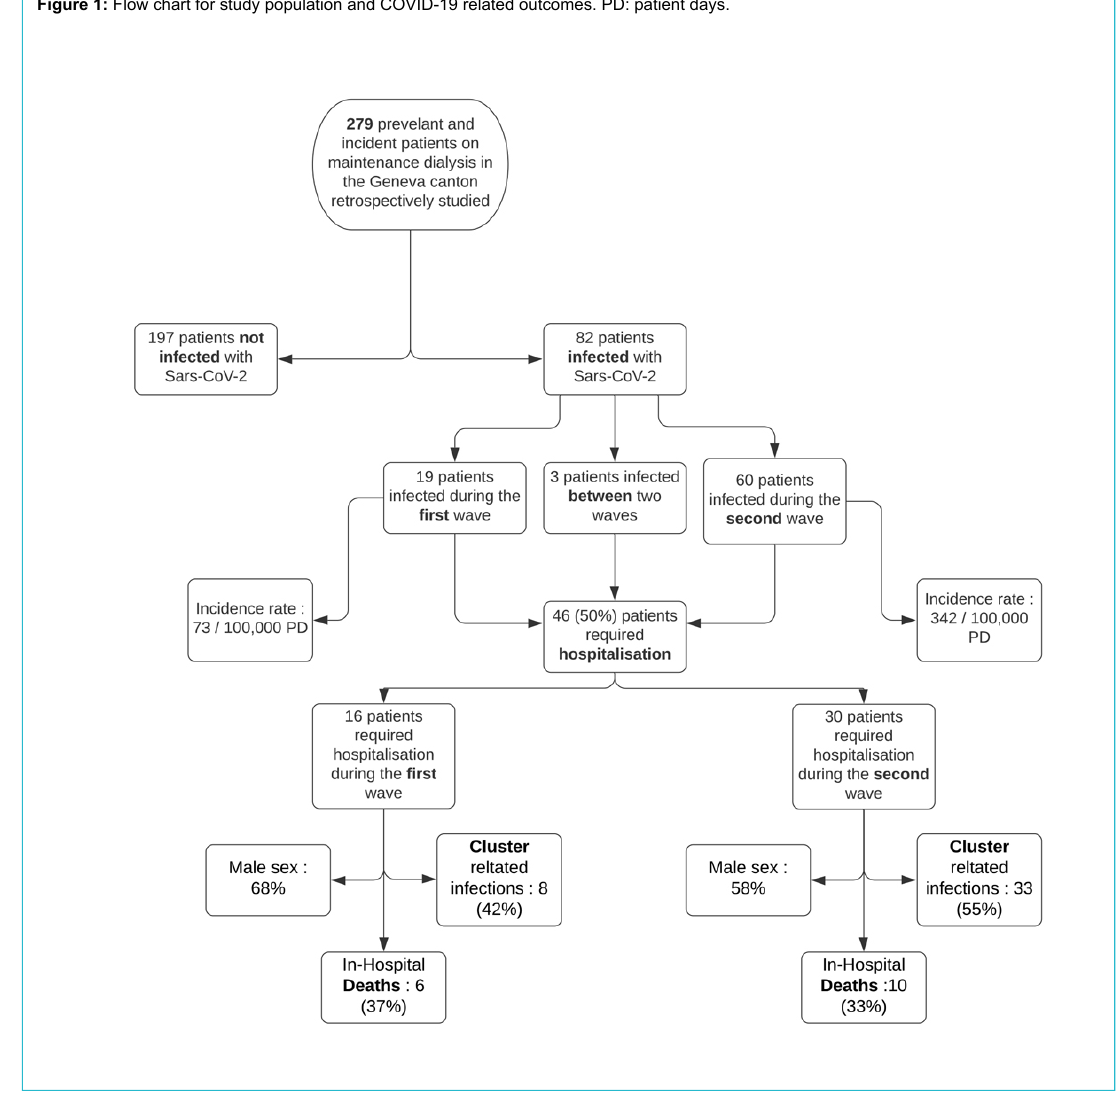
Figure 1: Flow chart for study population and COVID-19 related outcomes. PD: patient